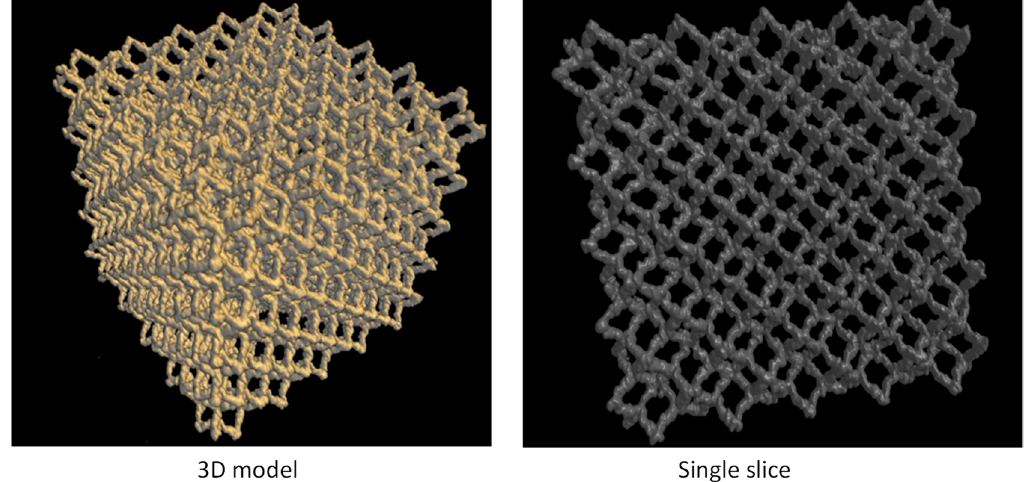
Figure 12. Micro-CT scan of dode thick cube for checking internal defects.